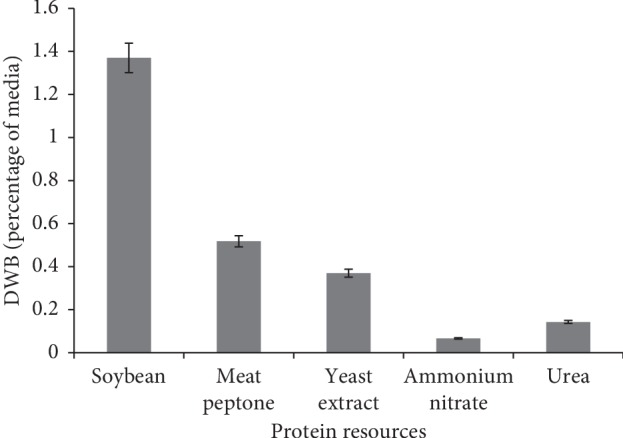
Effect of various protein sources on DWB.